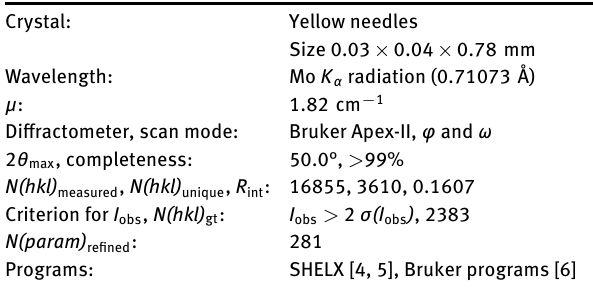
Table 1: Data collection and handling.